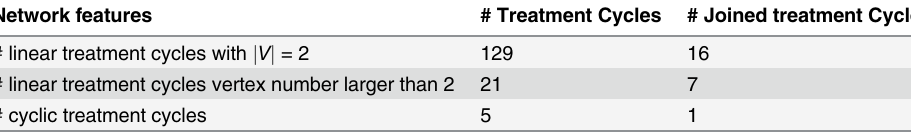
Table 4. Number of linear and cyclic treatment cycles inferred from the data. Network